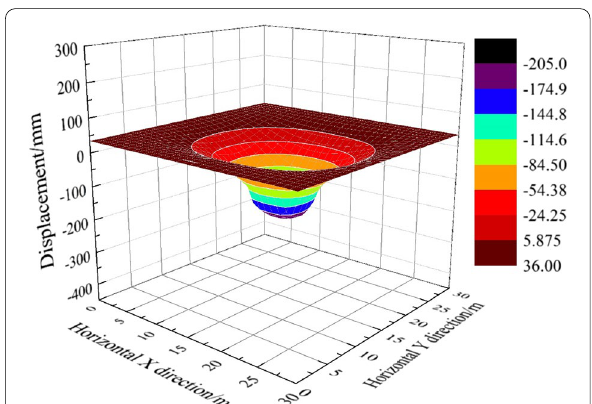
Fig. 8 Seismic subsidence of ground surface due to 0.30 g El Centro ground motion (full